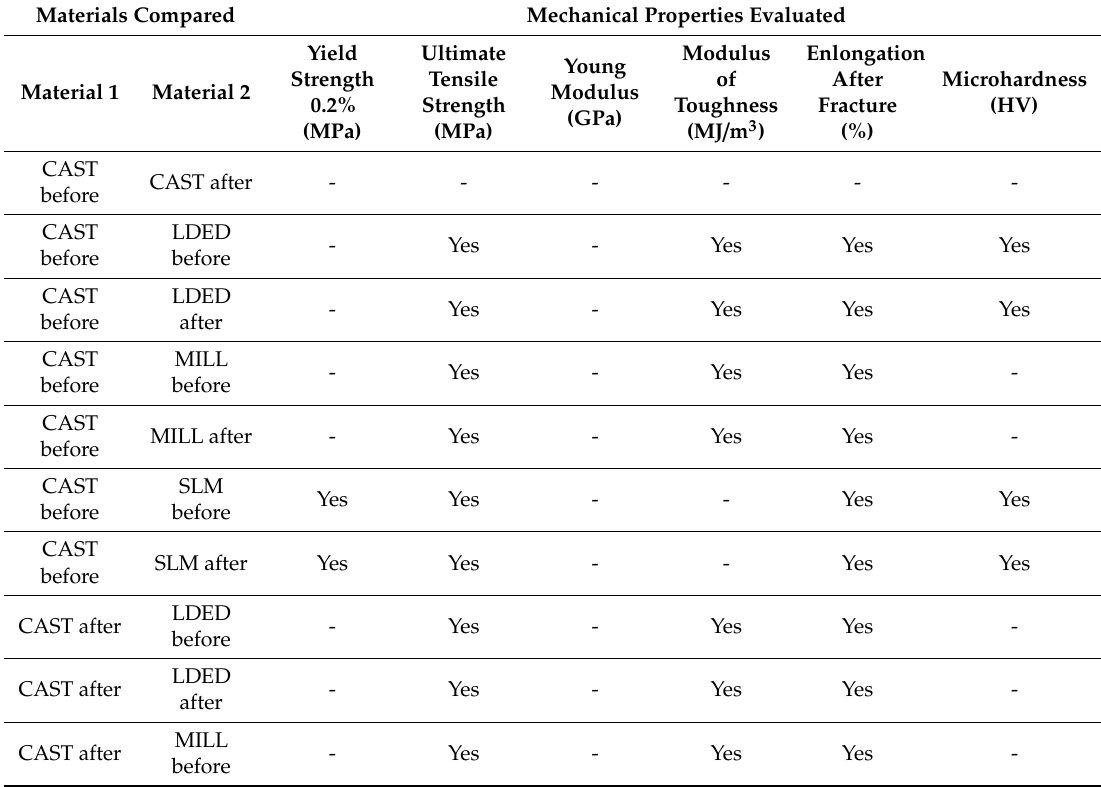
Table A1. Summary of the significant di ff erences ( p < 0.05) of the mechanical properties results. Materials